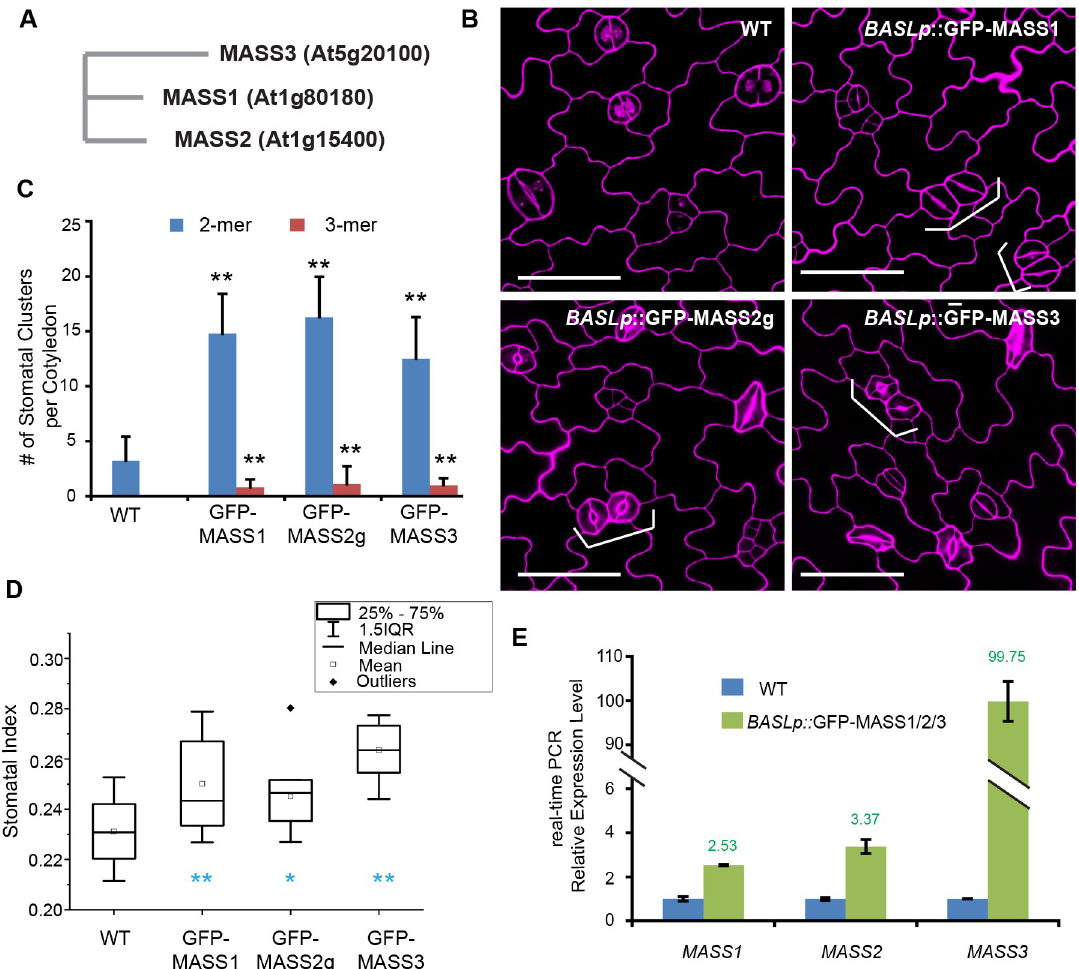
Fig 1. Stomatal phenotypes caused by MASS overexpression. (A) Phylogenetic tree of the Arabidopsis MASS family. (B) Stomatal phenotypes induced by MASS1/2/3. Confocal images of 3-dpg adaxial side of cotyledon epidermis in WT (Col) and overexpression seedlings of GFP-MASS1, GFP-MASS2g, and GFP-MASS3, all driven by the BASL promoter. Cell outlines were stained with propidium iodide (PI, magenta). Brackets indicate stomatal clusters. Scale bar represents 50 μ m. (C) Quantification of the numbers of stomatal clusters per cotyledon in 10-dpg seedlings of the designated plants. (D) Quantification of stomatal index (SI) in 5-dpg adaxial cotyledons of the designated seedlings. (E) Quantitative real-time PCR analysis of MASS1/2/3 expressions in WT and GFP-MASS transgenic lines in (B). � significantly different compared with the WT (Col) values (Student’s t -test, � P < 0.05, �� P <